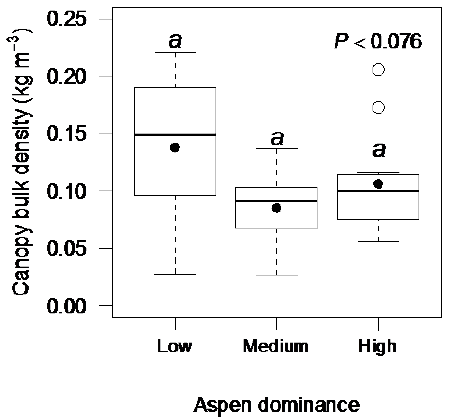
Figure 2. Canopy bulk density (kg·m − 3 ) for three aspen dominance classes. For each box plot the box represents the 1st and 3rd quartiles, whiskers denote 1.5 times the interquartile range, the heavy horizontal line inside the boxes indicates the median, filled circles indicate the mean, and unfilled circles indicate outliers. Different letters denote significant differences at the 95% level using a Tukey HSD test. Aspen dominance classes: low, 0%–33%, medium, 34%–66%, and high, 67%–100%.